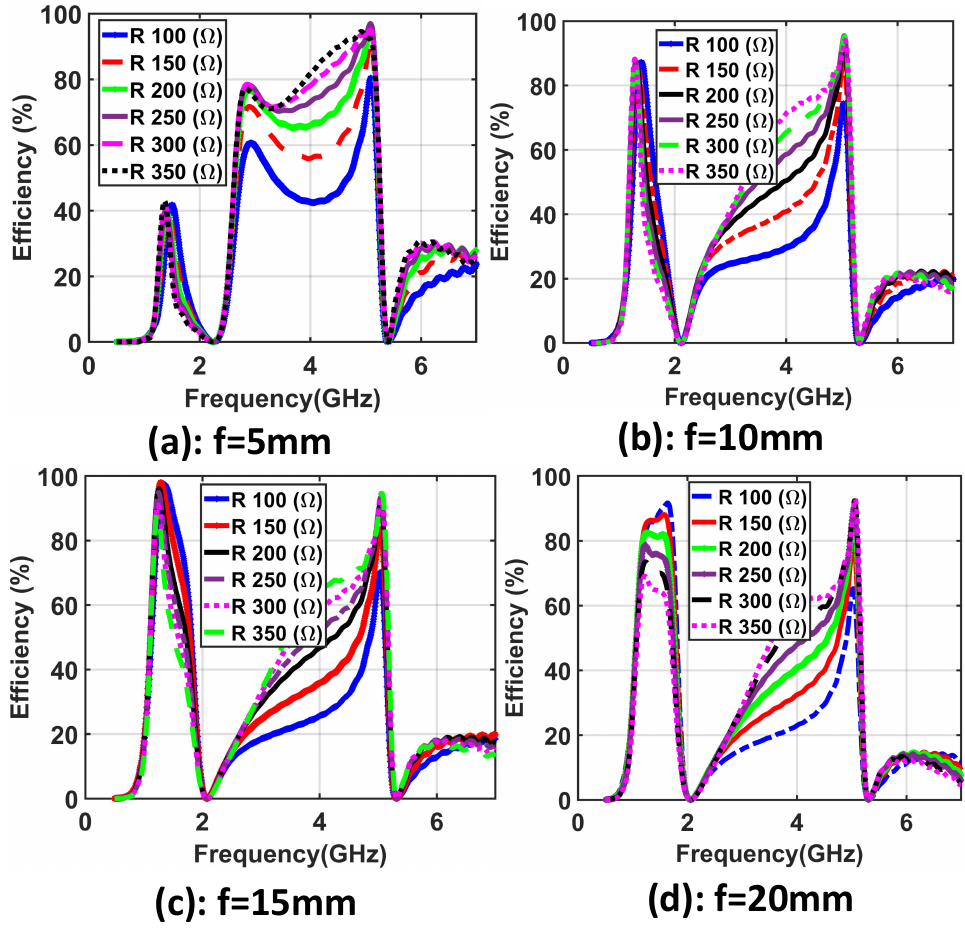
Figure 3. Results of the introduced unit cell demonstrating the efficiency using different values of the R load from 100 Ω to 350 Ω and using four cases of f : ( a ) f = 5 mm, ( b ) f = 10 mm, ( c ) f = 15 mm, and ( d ) f = 20